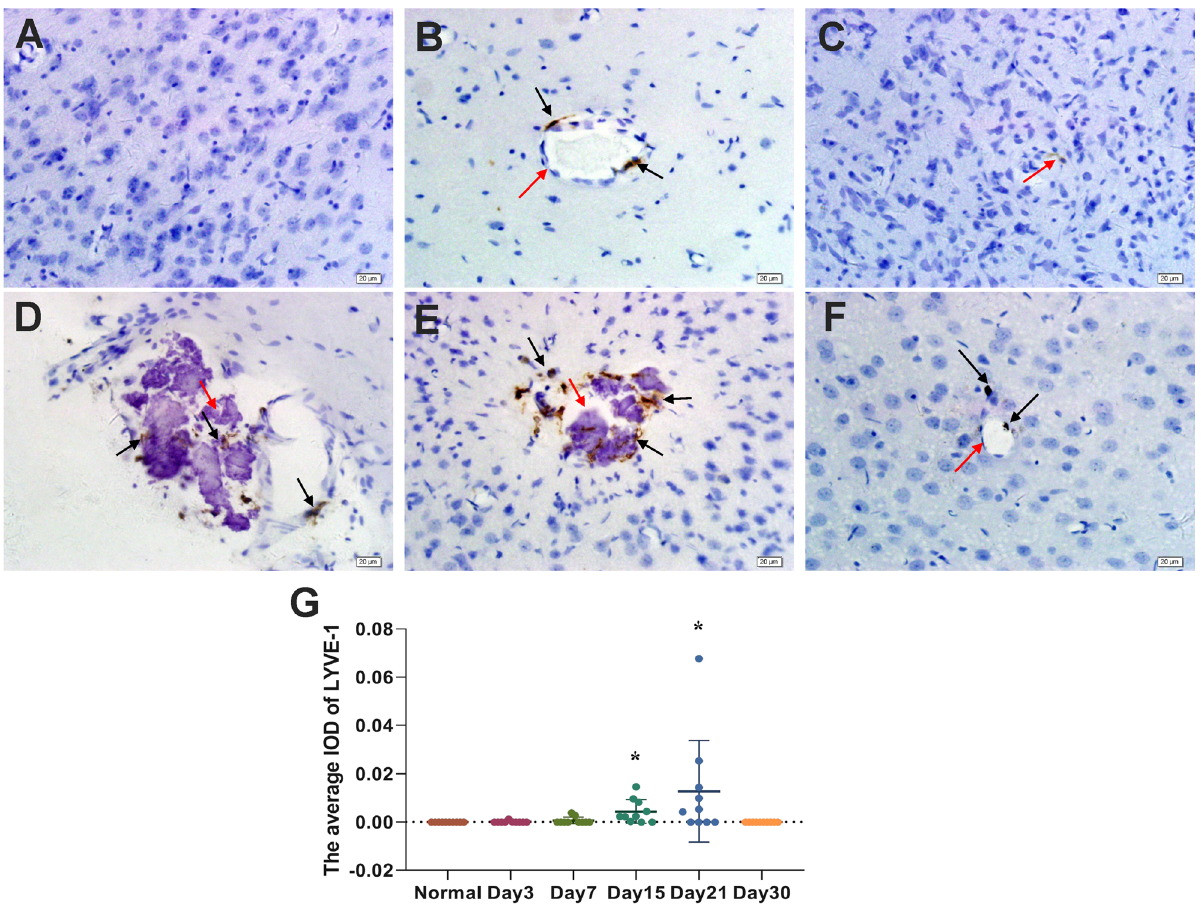
Figure 2. Immunohistochemical staining images showing LYVE-1 expression in ( A ) normal mouse brain tissue and ( B – F ) mouse brain tissue on days 3, 7, 15, 21 and 30 days, following pTBI. ( A ) LYVE-1 was not expressed in normal mouse brain tissue. ( B ) LYVE-1-positive (brown; black arrow) vascular endothelial cells became visible around the injury site (lesion indicated with a red arrow) on day 3. ( C ) LYVE-1-positive vascular endothelial cells were clearly visible on day 7. LYVE-1-positive cells (black arrows) were observed at the injury site (red arrow) on days ( D ) 15 and ( E ) 21. ( F ) LYVE-1-positive cells were no longer visible at the injury site (red arrow) on day 30, but black hemosiderin particles (black arrows) were observed. ( G ) Immunohistochemical results of LYVE-1 were analyzed by Image-Pro Plus 6.0 software. The average density (IOD) of LYVE-1-positive cells in normal mouse brain tissue and in mouse brain tissue on days 3, 7, 15, 21 and 30 days, following pTBI. The n = 10/group was used for calculating the average IOD. Comparisons between groups were performed using the Kruskal–Wallis H test followed by Bonferroni post-hoc